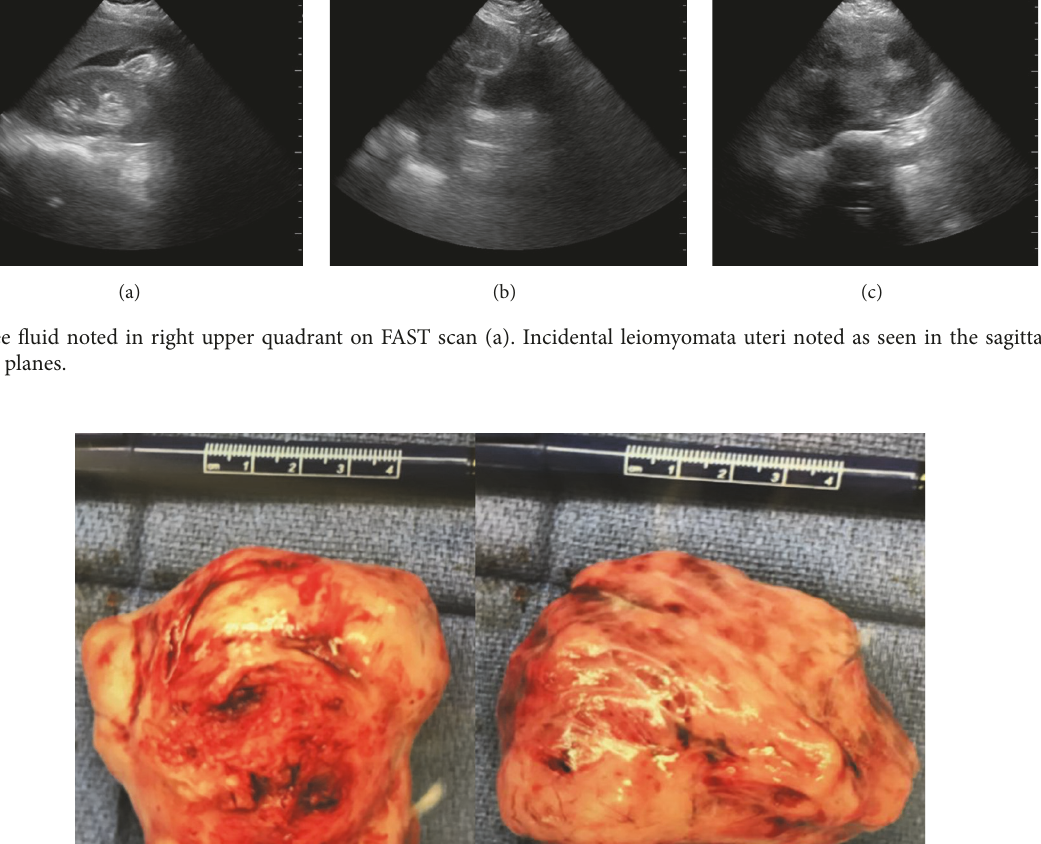
(Figures 1(b) and 1(c)). A pelvic X-ray showed no acute fracture or traumatic malalignment. Hemoglobin was